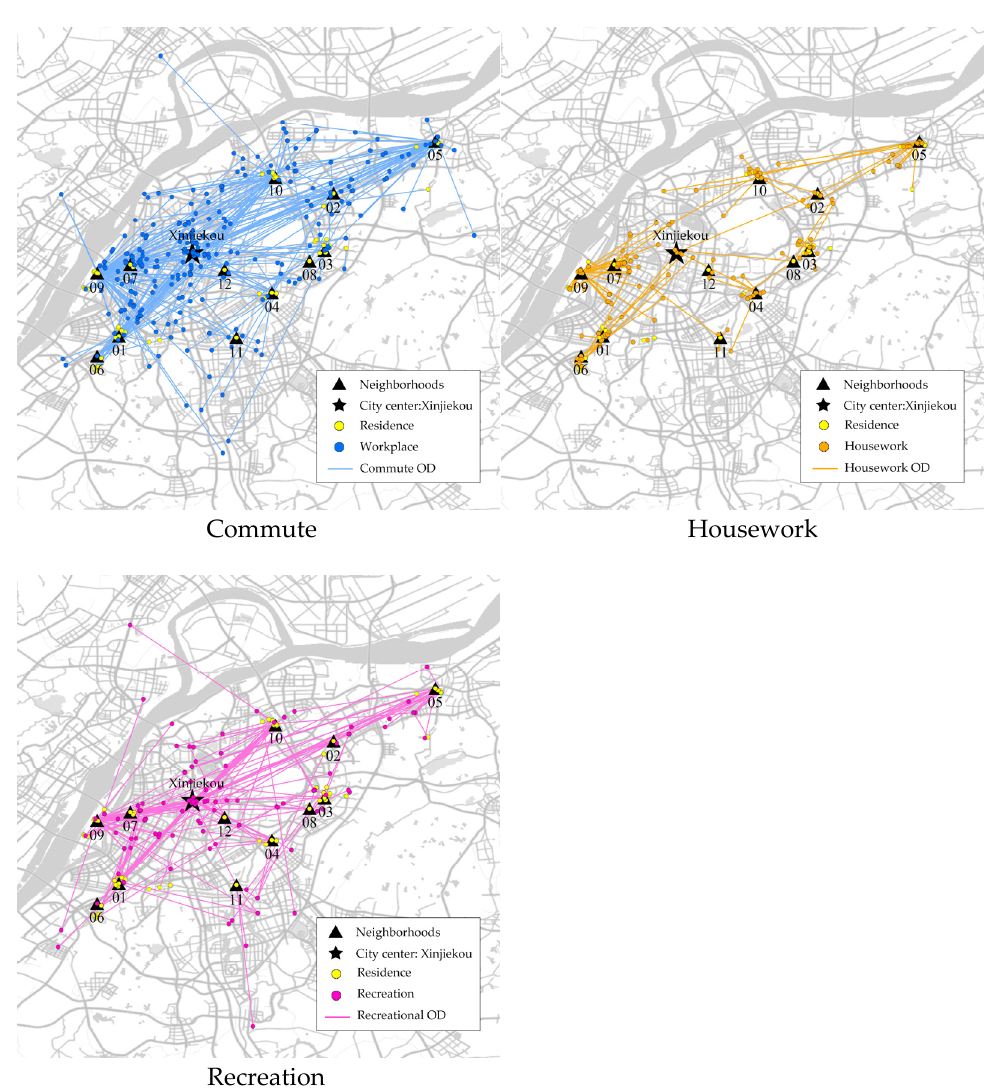
Figure 3. The distribution of samples’ travel origin, destination and travel flow.